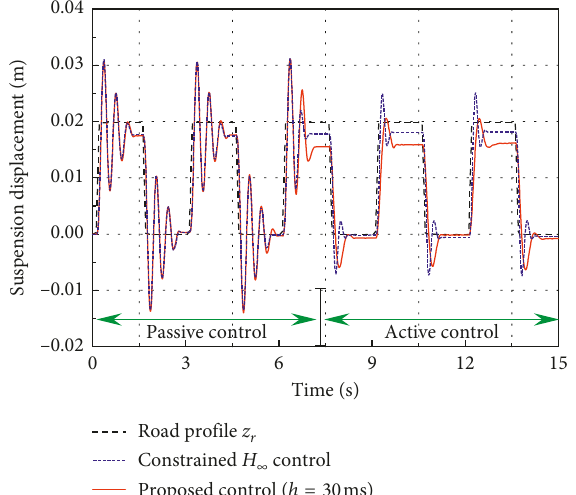
Figure 13: Hardware results of active control force under square wave signal.